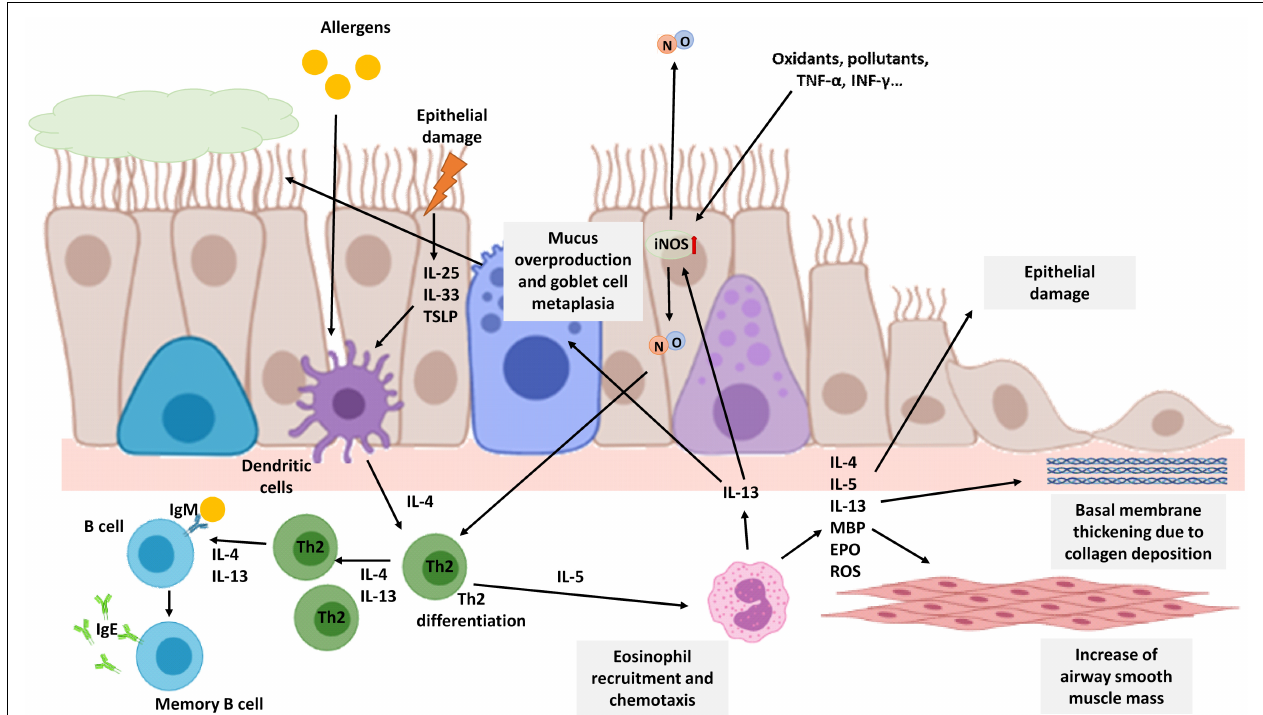
FIGURE 3 | Schematic view of T2 eosinophilic airway inflammation in the pathophysiology of asthma. Allergens or epithelial damage activates dendritic cells that secrete cytokines, such as IL-4, leading to Th2 differentiation. Th2 lymphocytes secrete IL-4 and IL-13 amplifying Th2 proliferation and promoting the generation of IgE by B lymphocytes. Th2 cells also secrete IL-5, the most important cytokine for eosinophil recruitment. IL-13 secreted mainly by eosinophils activates iNOS expression increasing NO levels in the airways and consequently F E NO. NO, in turn, is also involved in Th2 differentiation. Moreover, iNOS expression on epithelial cells could be also enhanced by oxidants, pollutants, or proinflammatory stimuli such as TNF- α or INF- γ . Chronic eosinophil inflammation is involved in tissue airway remodeling and bronchial obstruction caused by an increase of airway smooth muscle mass, epithelial cell hyperplasia, goblet cell metaplasia, mucus overproduction, and basement membrane thickening caused by deposition of extracellular matrix proteins. The image has been created with